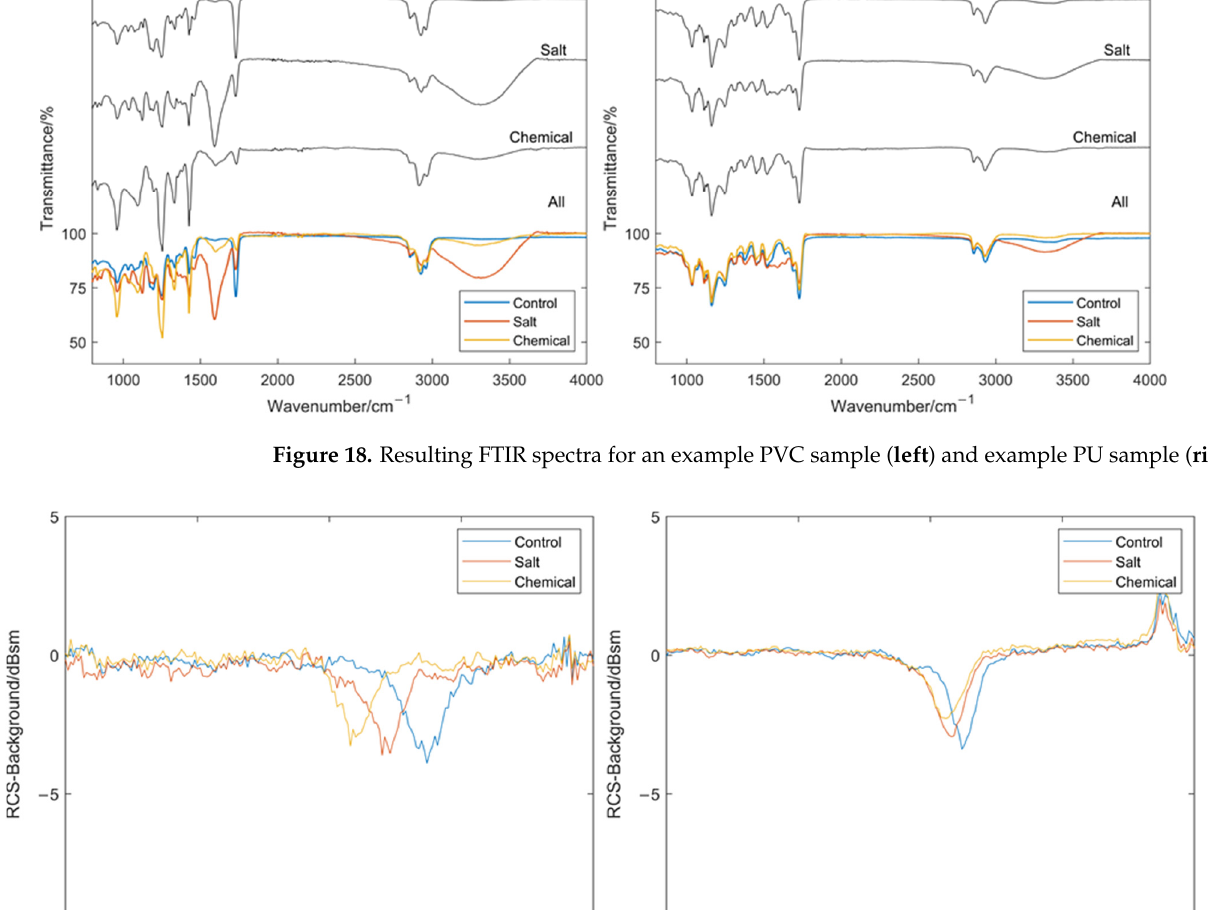
Figure 18. Resulting FTIR spectra for an example PVC sample ( left ) and example PU sample ( right ).